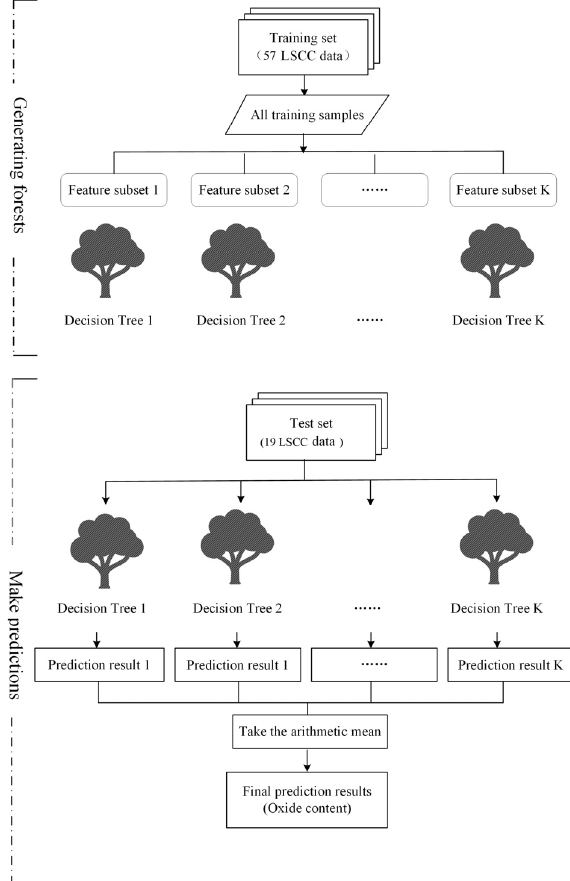
Figure 2. Flow chart of the Extra-Trees model.